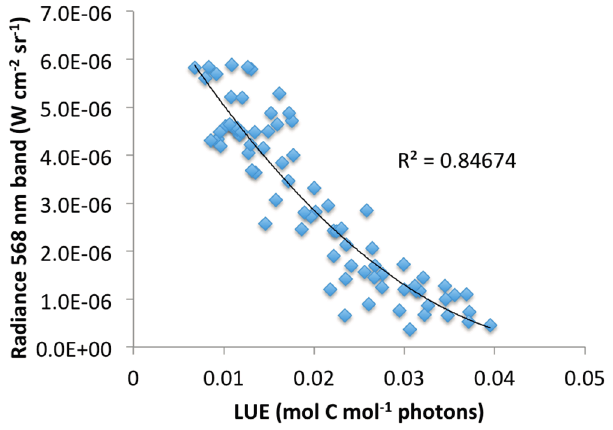
Figure 8. Scatter plot showing the relationship between the daily averaged photochemical reflectance index (PRI) and daily-averaged light use efficiency (LUE) that was derived with the eddy-covariance technique, and selected for times between 8 a.m. and 4 p.m. Pacific standard time.